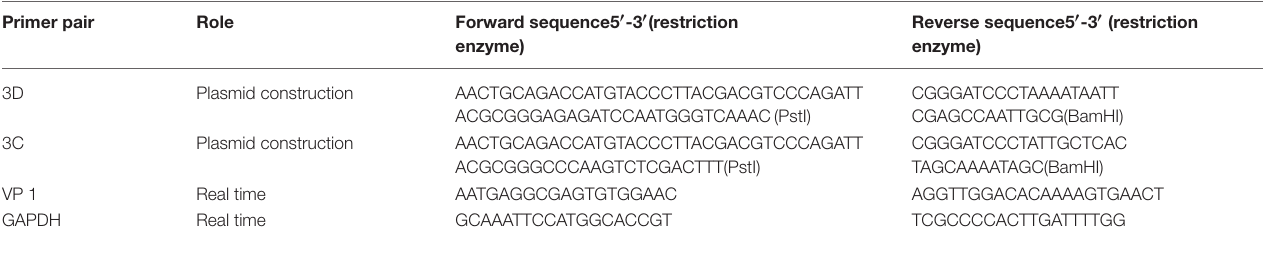
TABLE 1 | The primer for real time PCR and plasmid construct. Primer